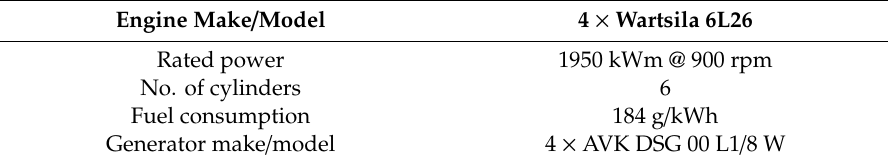
Table 3. Technical specifications of diesel